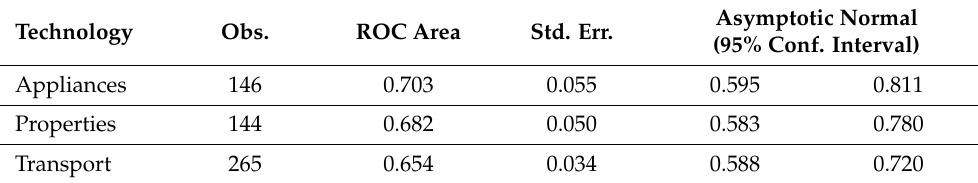
Table 14. Comparison of the ROC areas—technology subsample models (firms).